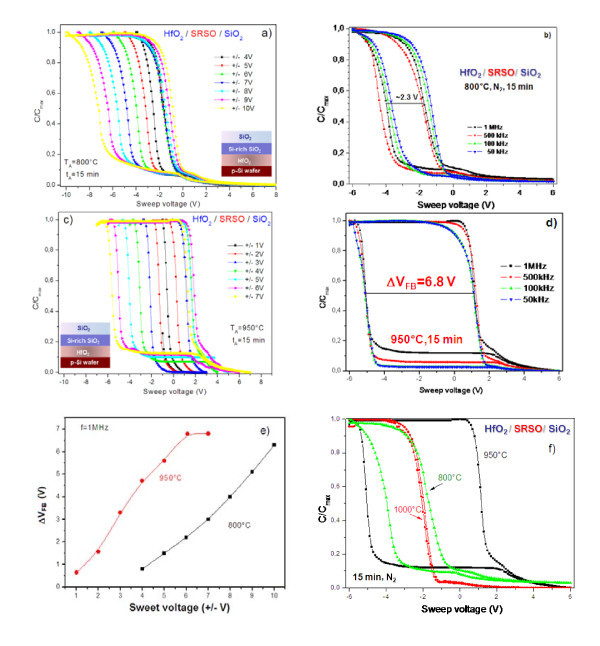
C-V characteristics of annealed HfO2/SRSO/SiO2. C-V characteristics of HfO2/SRSO/SiO2 annealed at 800°C for 15 min (a, b) and at 950°C for 15 min (c, d) measured at 1 MHz (a, c) and versus frequency measured at 6 V sweep voltage (b, d). (e) The variation of ΔVfb versus sweep voltage for two annealing temperatures; (f) the comparison of C-V curves measured at 1 MHz versus annealing temperature. Annealing time is 15 min for all the figures.